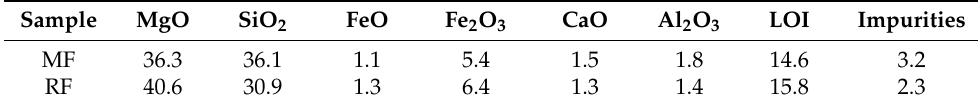
Table 1. Composition of serpentine samples by XRF